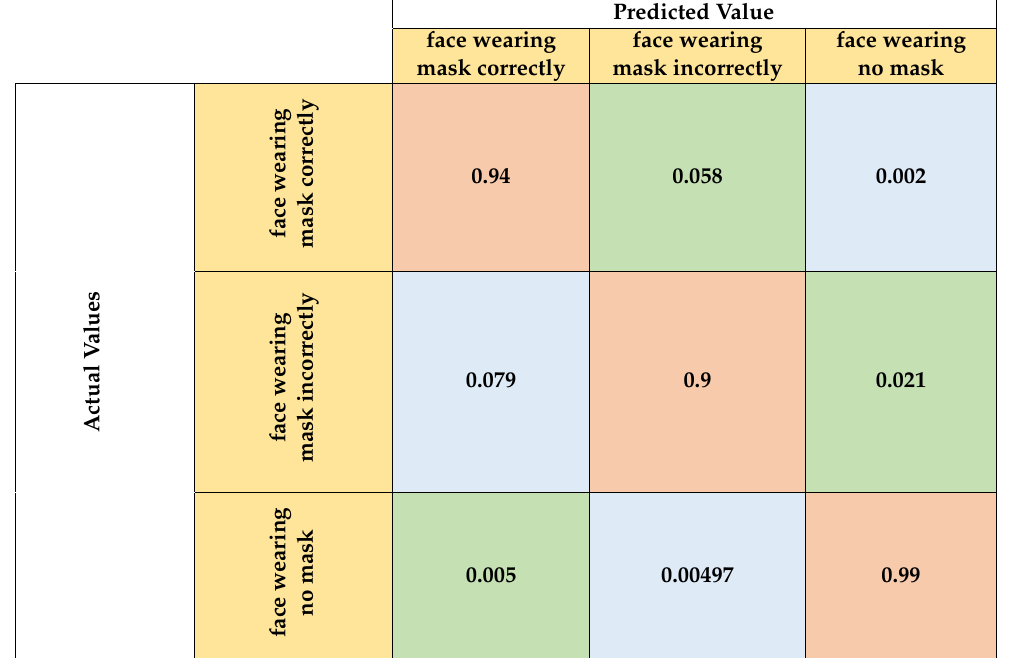
Table 2. Confusion matrix results for all comparison